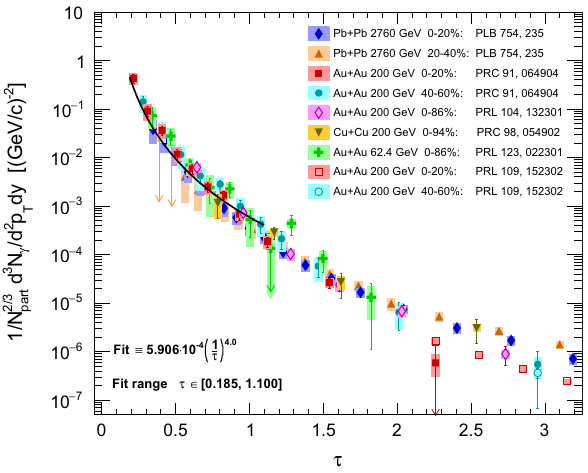
Fig. 3 Direct photon p T -spectra from Fig. 1 exhibit geometrical scal- ing when plotted in terms of the scaling variable τ (at λ ≈ 0 . 2) and / 3 divided by S T ∼ N 2 part . The black curve corresponds to another power- law fit, the details of which are shown in the plot. See the next sections for more